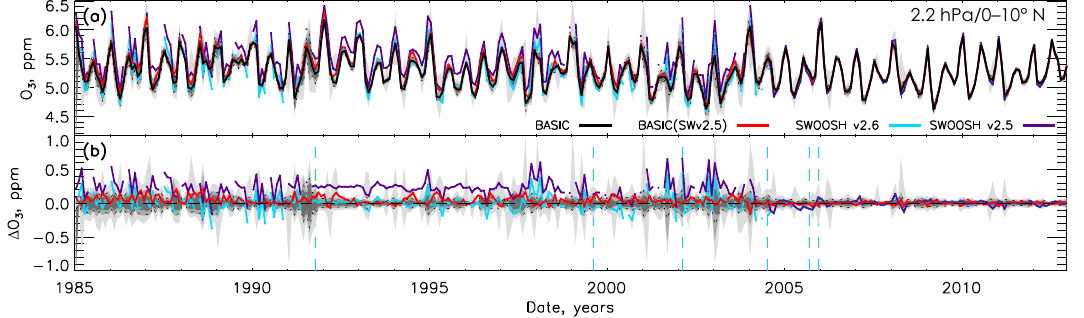
Figure A8. Ozone time series from 1985 to 2012, all bias shifted to the mean of SWOOSH v2.6 after August 2005. (a) Absolute ozone at 2.2hPa over 0–10 ◦ N from SWOOSH v2.6 (light blue), SWOOSH v2.5 (purple), BASIC using SWOOSH v2.5 (red), and the BASIC composite using SWOOSH v2.6 (black, with shading representing 68% (dark grey), 95% (grey), and 99% (light grey) credible intervals (CIs), and 2 standard deviations (dotted lines)). Panel (b) is the same as (a) but for the difference relative to BASIC (SWOOSHv2.6).